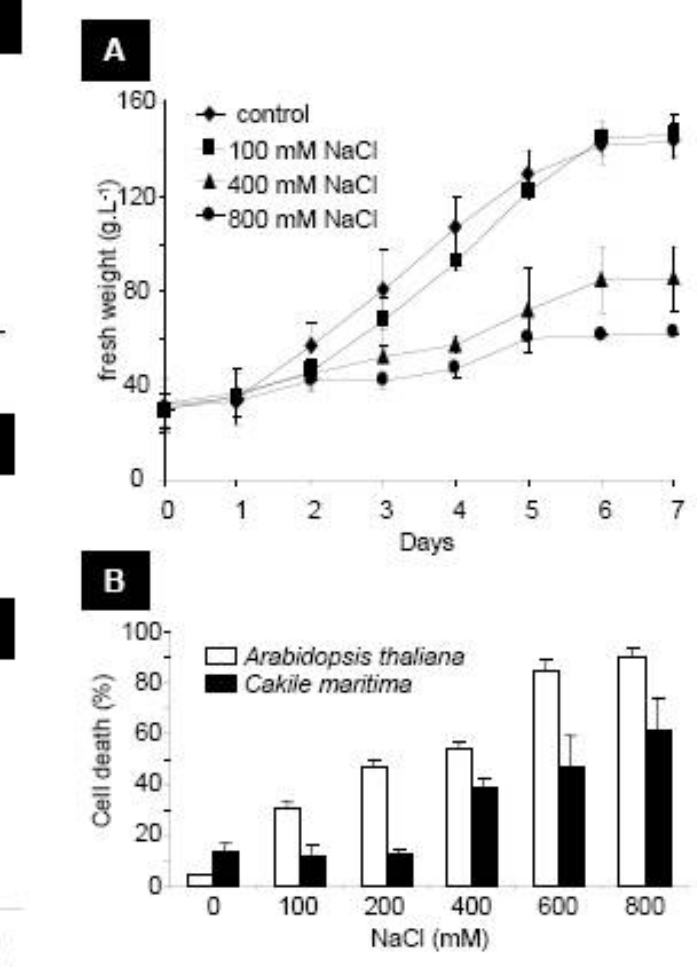
Fig. 6 - Evaluation of Cakile maritima cell suspension resistance to salinity. (A) Growth pattern of cell suspensions grown in pres- ence of 100, 400 or 800 mM NaCl determined by fresh weight measurement (B). Comparison of cell death extents of C. ma- ritima and Arabidopsis thaliana cell suspensions treated 6 h with NaCl concentrations ranging from 100 to 800 mM. Bars indicate mean ± SD of three